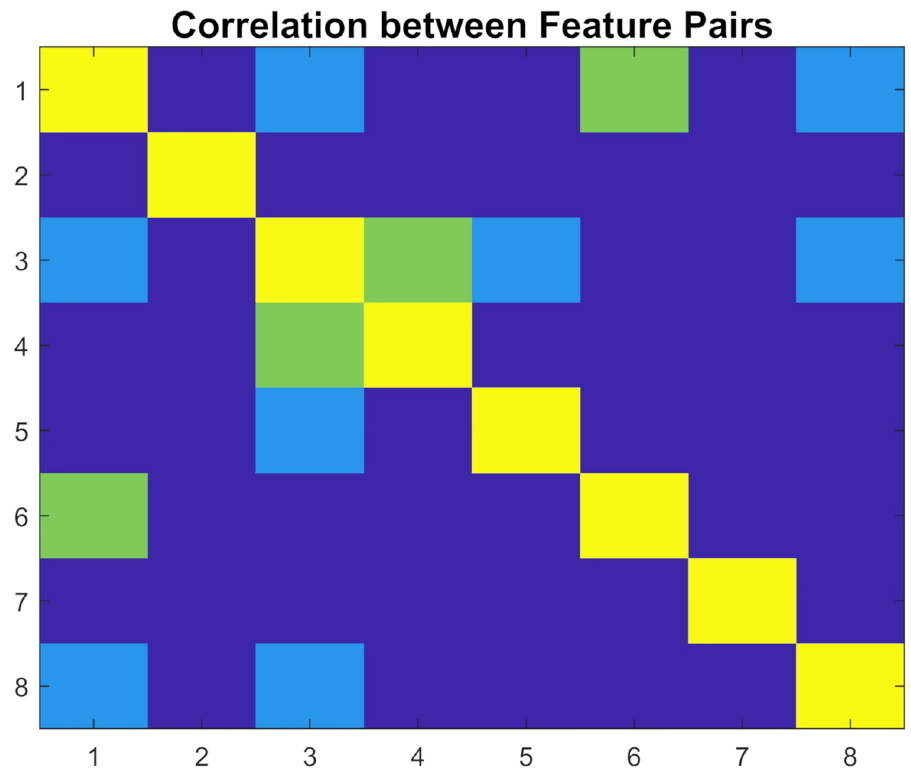
Fig 6. Correlation of feature pairs as measured using Pearson’s correlation coefficient. Yellow indicates perfect correlation (on the diagonal between the same features). Green, light blue, and dark blue show the pairs with moderate, low, and negligible correlations